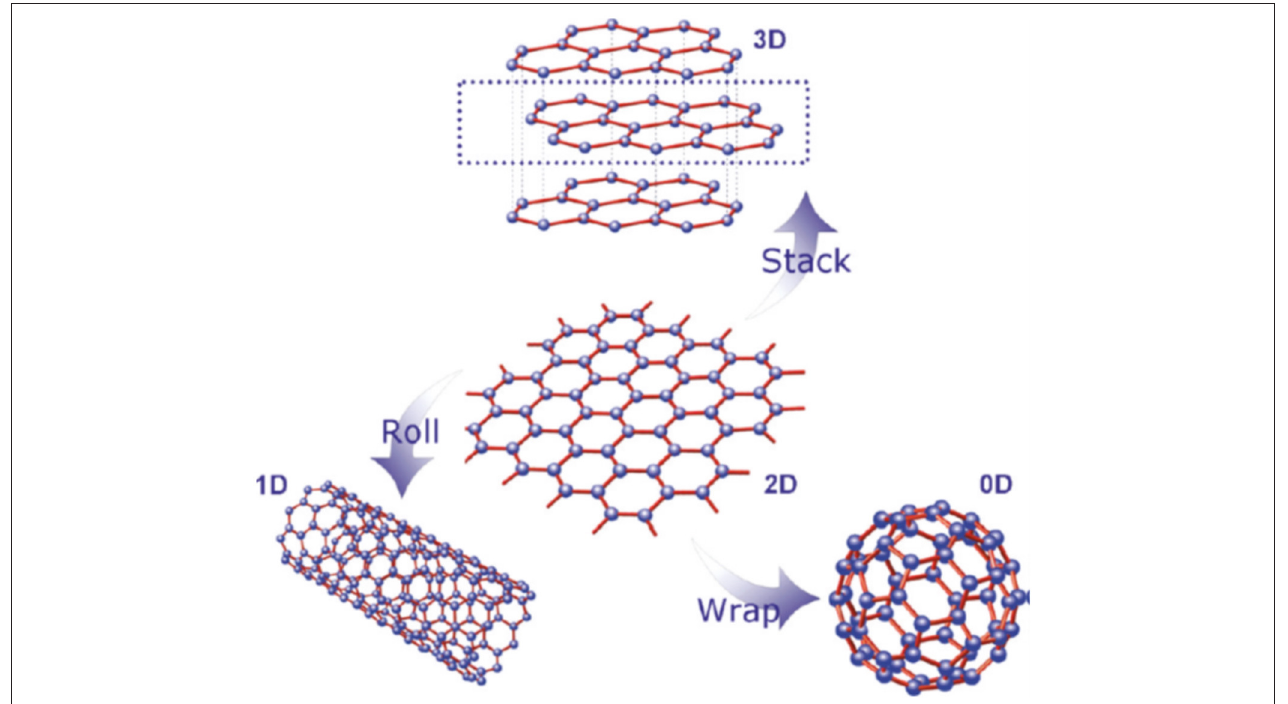
FIGURE 1 | The graphene building block for various carbon allotropes [Reproduced from Wan et al. (2012) with permission of American Chemical